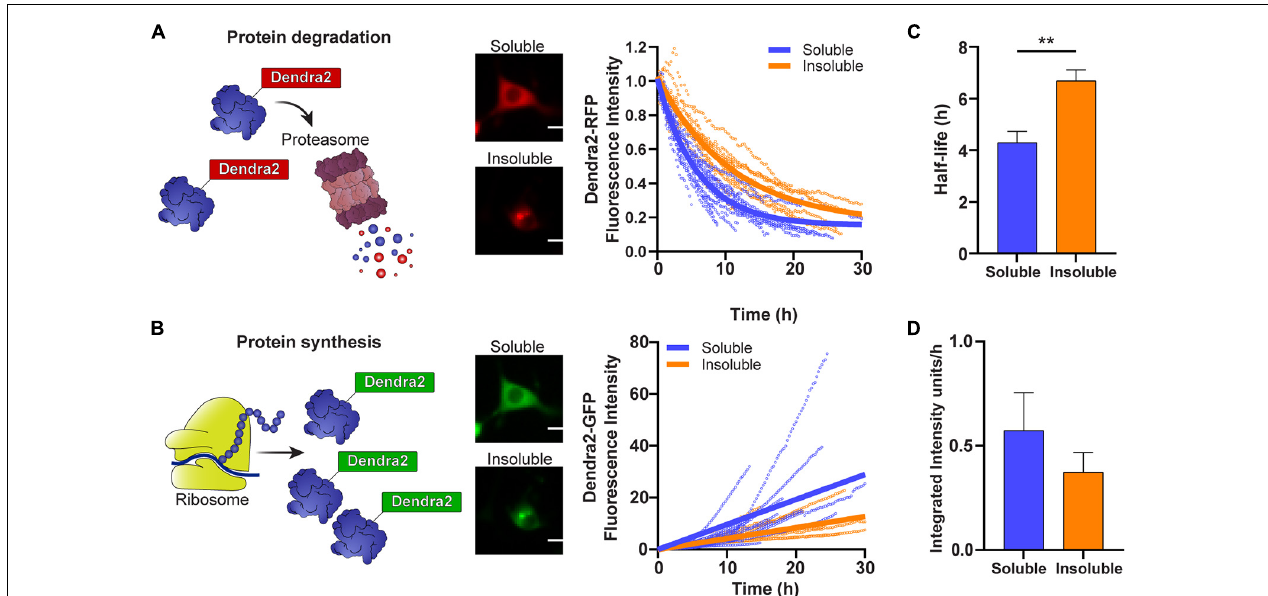
FIGURE 2 | The degradation and synthesis of SOD1 are slowed in cells containing insoluble aggregates. (A) The degradation of SOD1-Dendra2-RFP signal and (B) synthesis of SOD1-Dendra2-GFP signal was tracked in NSC-34 cells expressing soluble or insoluble SOD1 A4V over 30 h. Data shown are representative of non-linear and linear regression curves (solid lines) and individual cell traces ( n = 18 soluble SOD1 A4V , n = 12 insoluble SOD1 A4V ) from one replicate. (C) The half-life and (D) synthesis rate of SOD1 were determined from the Dendra2 signal in NSC-34 cells expressing soluble and insoluble SOD1 A4V -Dendra2. Data represent mean ± SEM ( n = 4 replicates, 59 single cell measurements, taken from data set in Figure 1 ). Statistical significance between groups was determined with an unpaired Student’s t -test (** p < 0.01). Scale bars: 10 µ